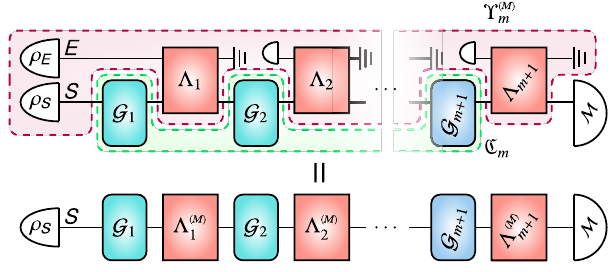
FIG. 2. A Markovianized counterpart of a non-Markovian RB sequence. Given a non-Markovian RB sequence with a noise process ϒ m , a Markovianized counterpart ϒ ( M ) can be given by one where the information carried in E is dissipated or lost between each step. The corresponding RB sequence has Marko- vian noise given by the CP maps (cid:3) ( M ) tr E ◦ (cid:3) n (ε n ⊗ σ) for any pure state ε n on E